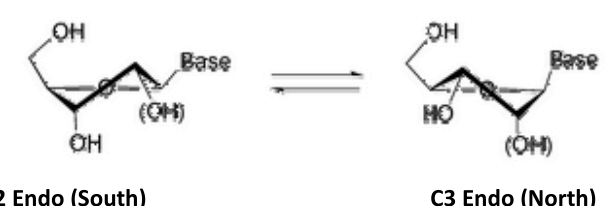
Figure 1. Nucleoside